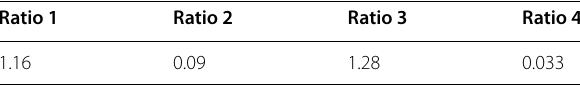
Table 5 Ratio of failure parameters for UHPC‑200.